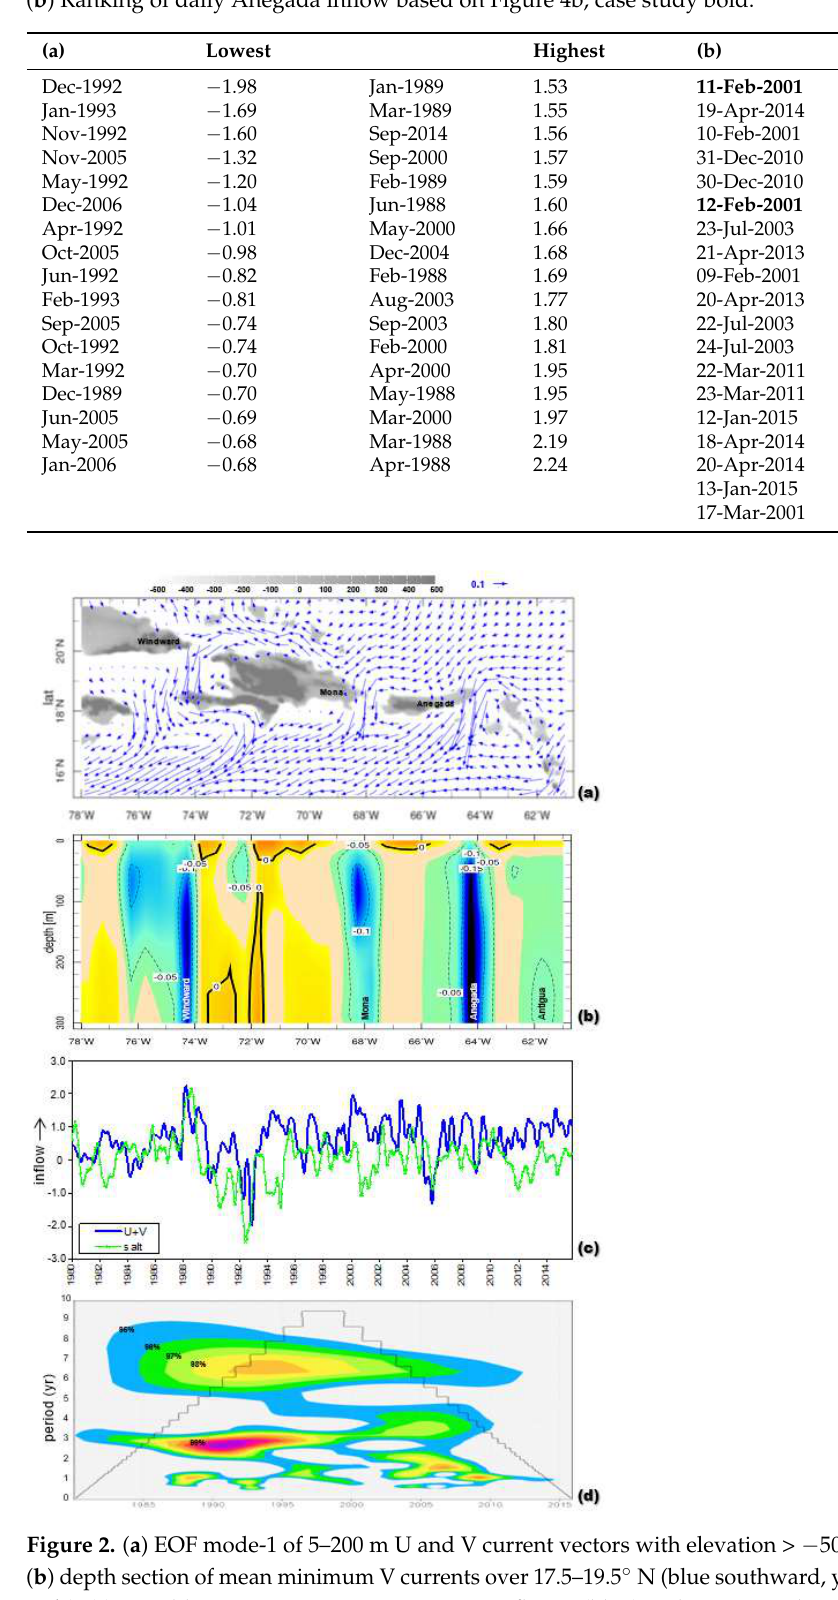
Table 2. ( a ) Ranking of monthly AMW inflow based on Figure 2c standardized time-scores. ( b ) Ranking of daily Anegada inflow based on Figure 4b, case study bold.